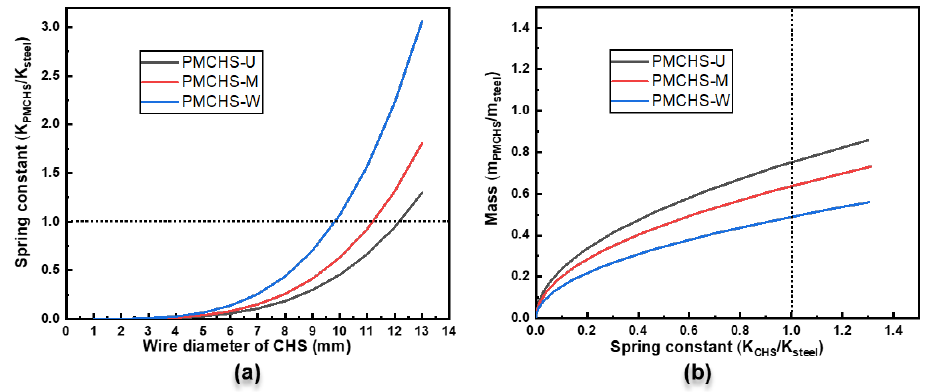
Figure 7. ( a ) The spring constant ratios of different PMCHSs to a steel spring with the increase in the wire diameter of the PMCHSs, and ( b ) the mass ratio of different PMCHSs to a steel spring with the increase in the spring constant ratio. The dot line means the PMCHS and steel springs having the same spring